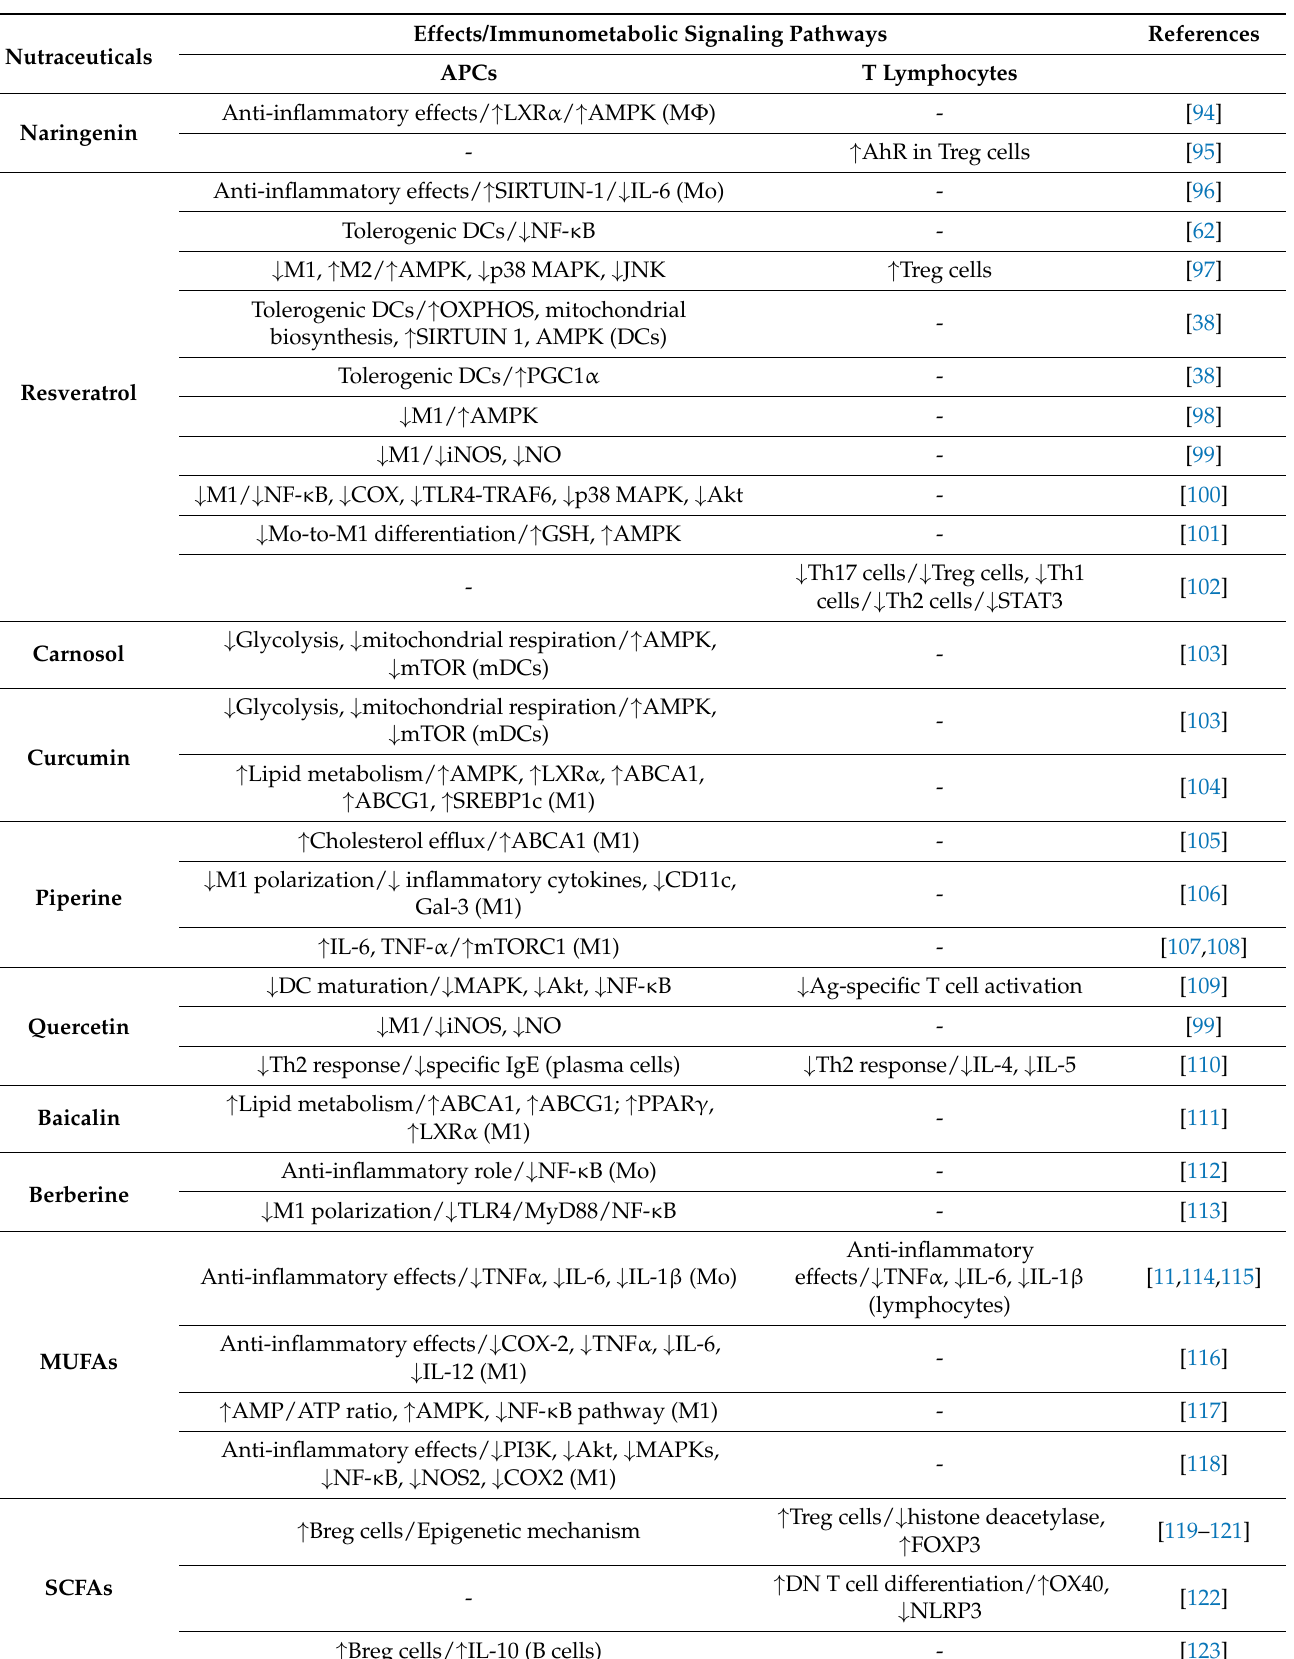
Table 1. Nutraceuticals with a modulator effect on immunometabolism.